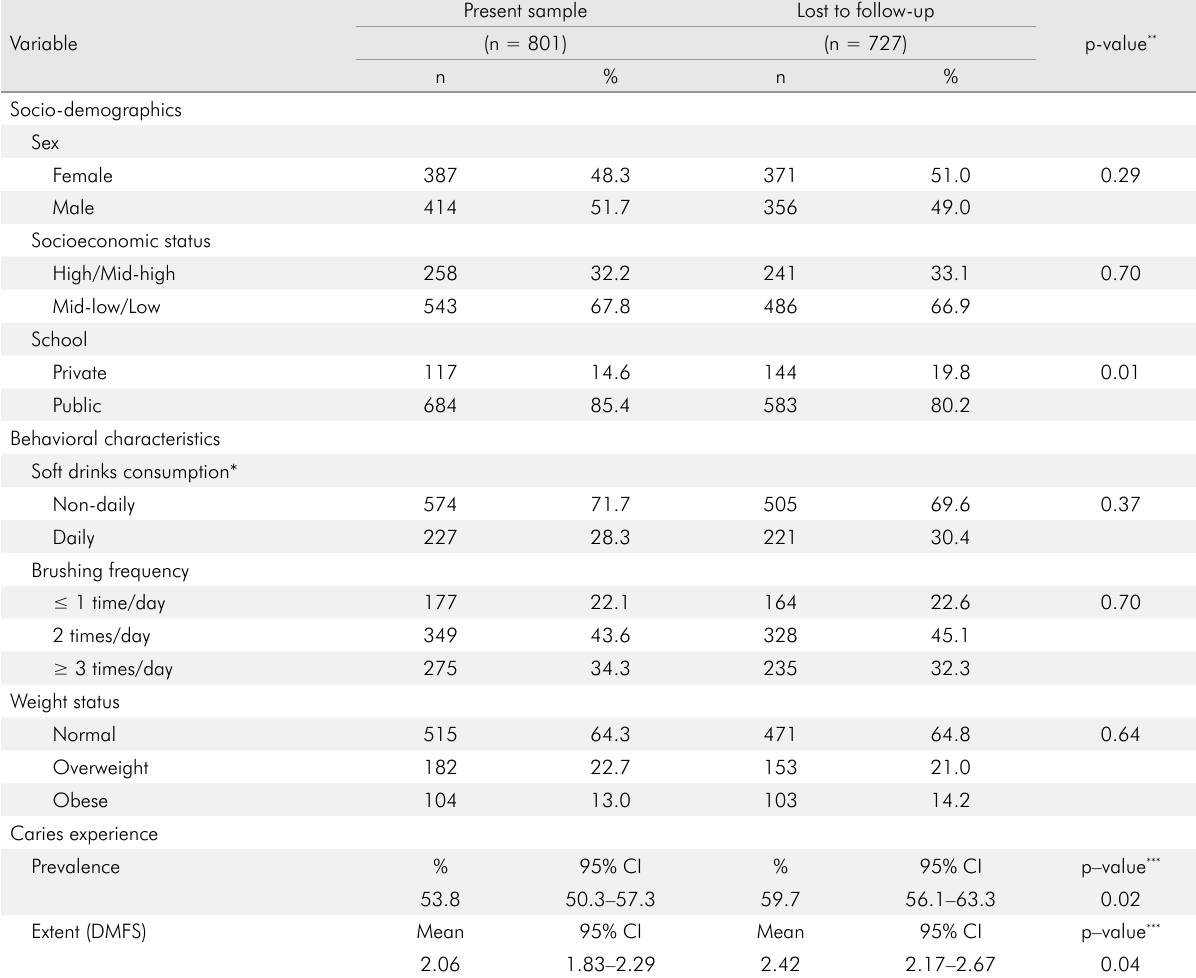
Table 1. Baseline characteristics of individuals according to participation at the follow up.